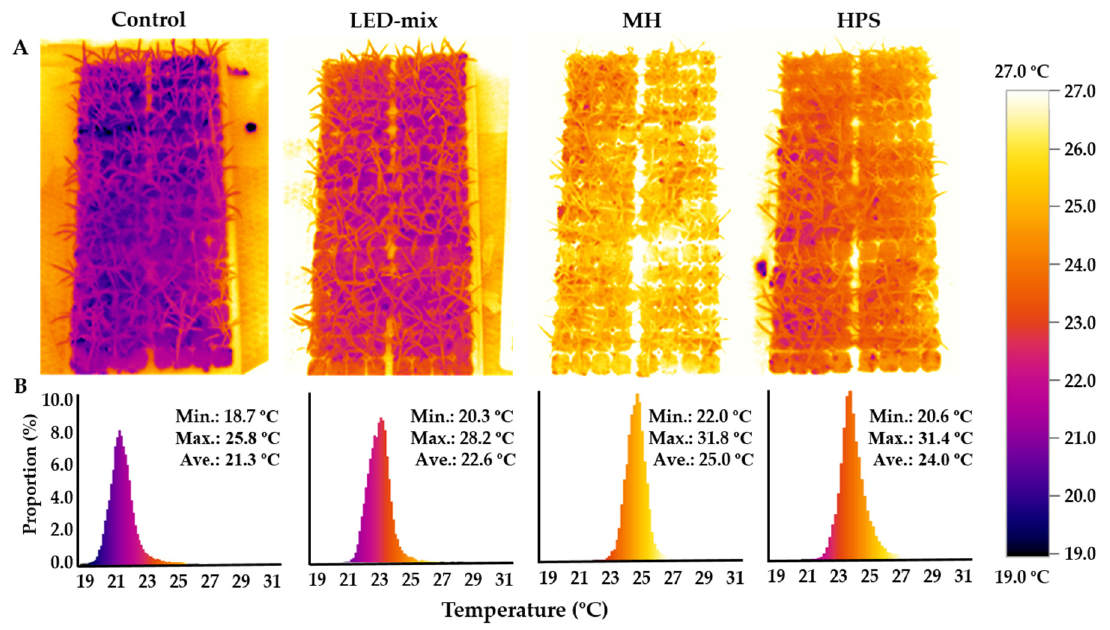
Figure 3. Thermal images of carnation ‘Dreambyul’ affected by the supplementary light source ( A ) and the temperature profiles ( B ). The images were taken 1 m above the cuttings at 13:00.